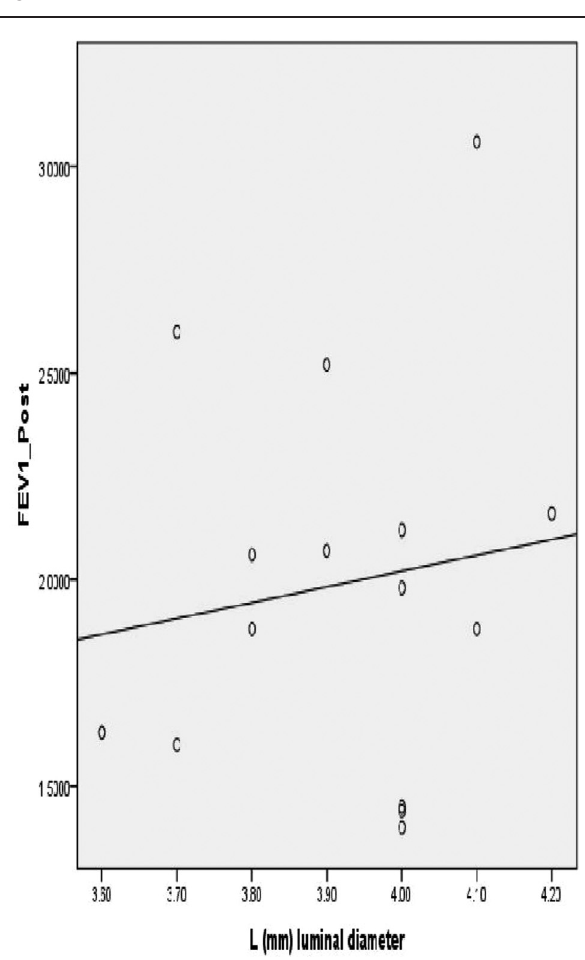
Correlation of a forced expiratory volume in 1s after bronchodilator therapy with airway internal diameter assessed in HRCT among patients with asthma – chronic obstructivepulmonary disease